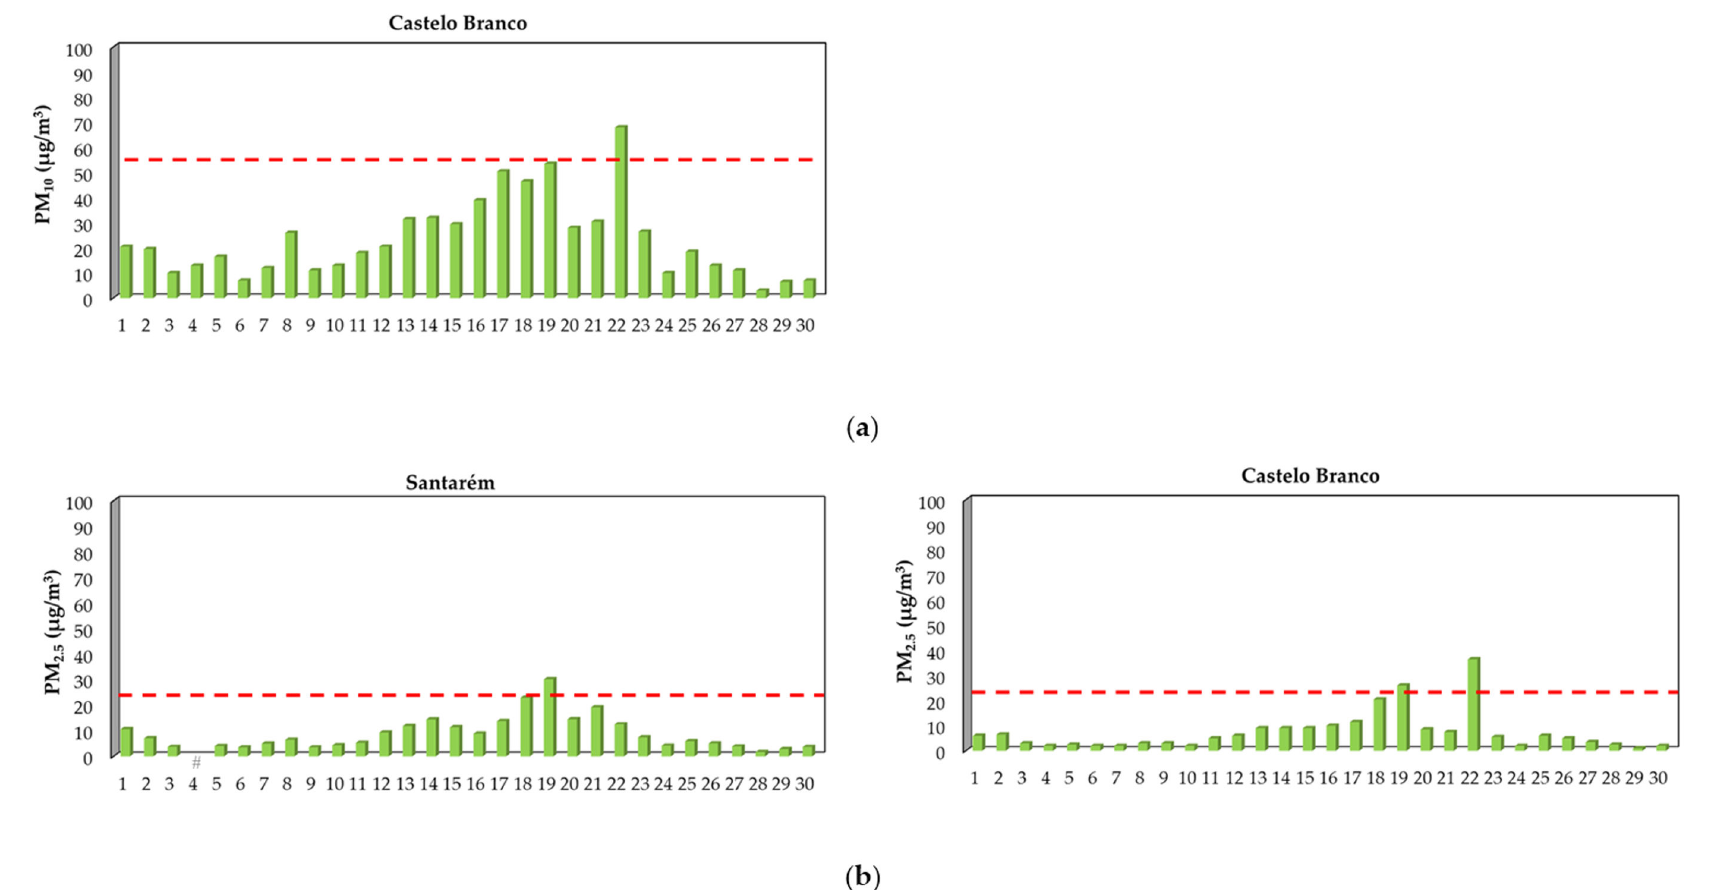
Figure 5. Daily concentrations (median, µ g / m 3 ) of PM 10 ( a ) and PM 2.5 ( b ) in the rural monitoring stations from the center region of Portugal during the month of June. Dashed lines represent the WHO guidelines of 50 and 25 µ g / m 3 [36]. # Data were not